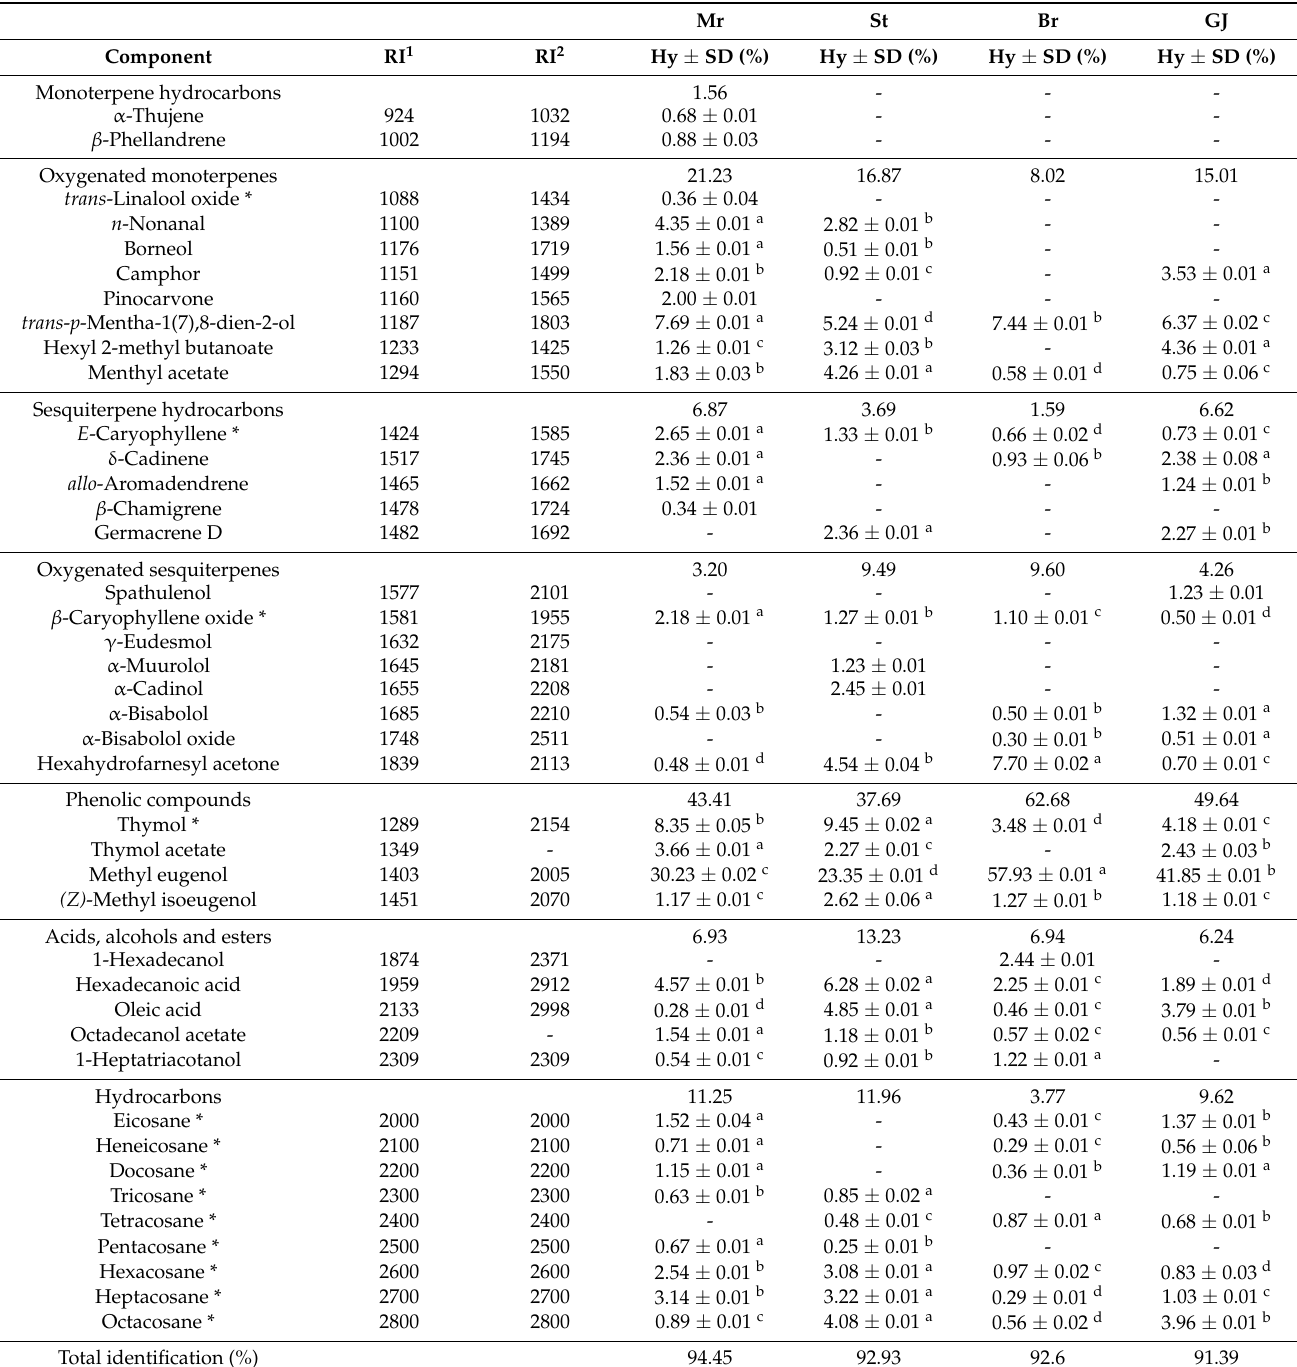
Table 2. Chemical composition of the hydrosols from four locations from aerial parts of Veronica austriaca ssp. jacquinii